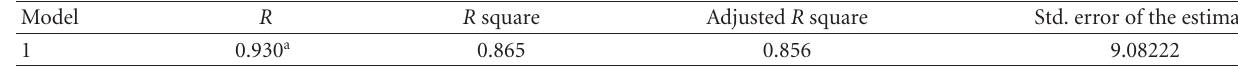
Table 1: Regression for model summary.